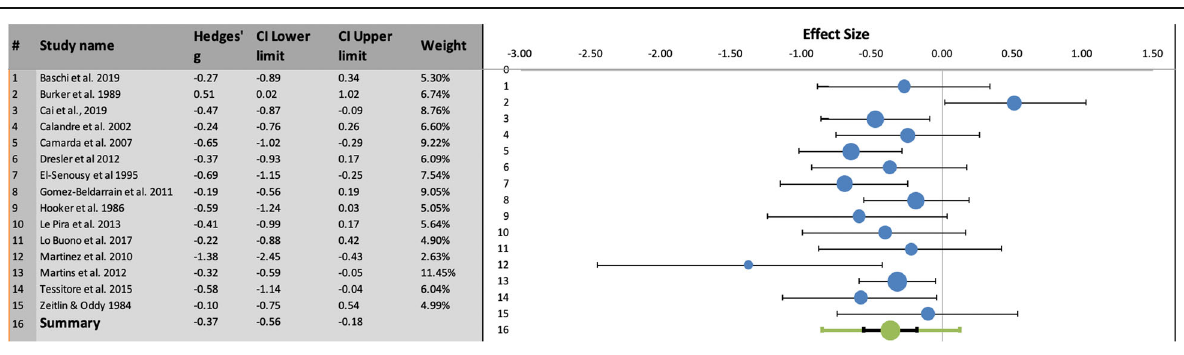
Fig. 3 Left: Summary results of meta-analysis regarding TMT-B performance differences between migraine patients and healthy controls, including Hedges ’ g, Confidence Intervals (CI) and relative weight of each study. Right: Forest plot showing the effect size (with confidence interval) of individual studies and, below, the combined effect size with its confidence interval (in black) and its prediction interval (in